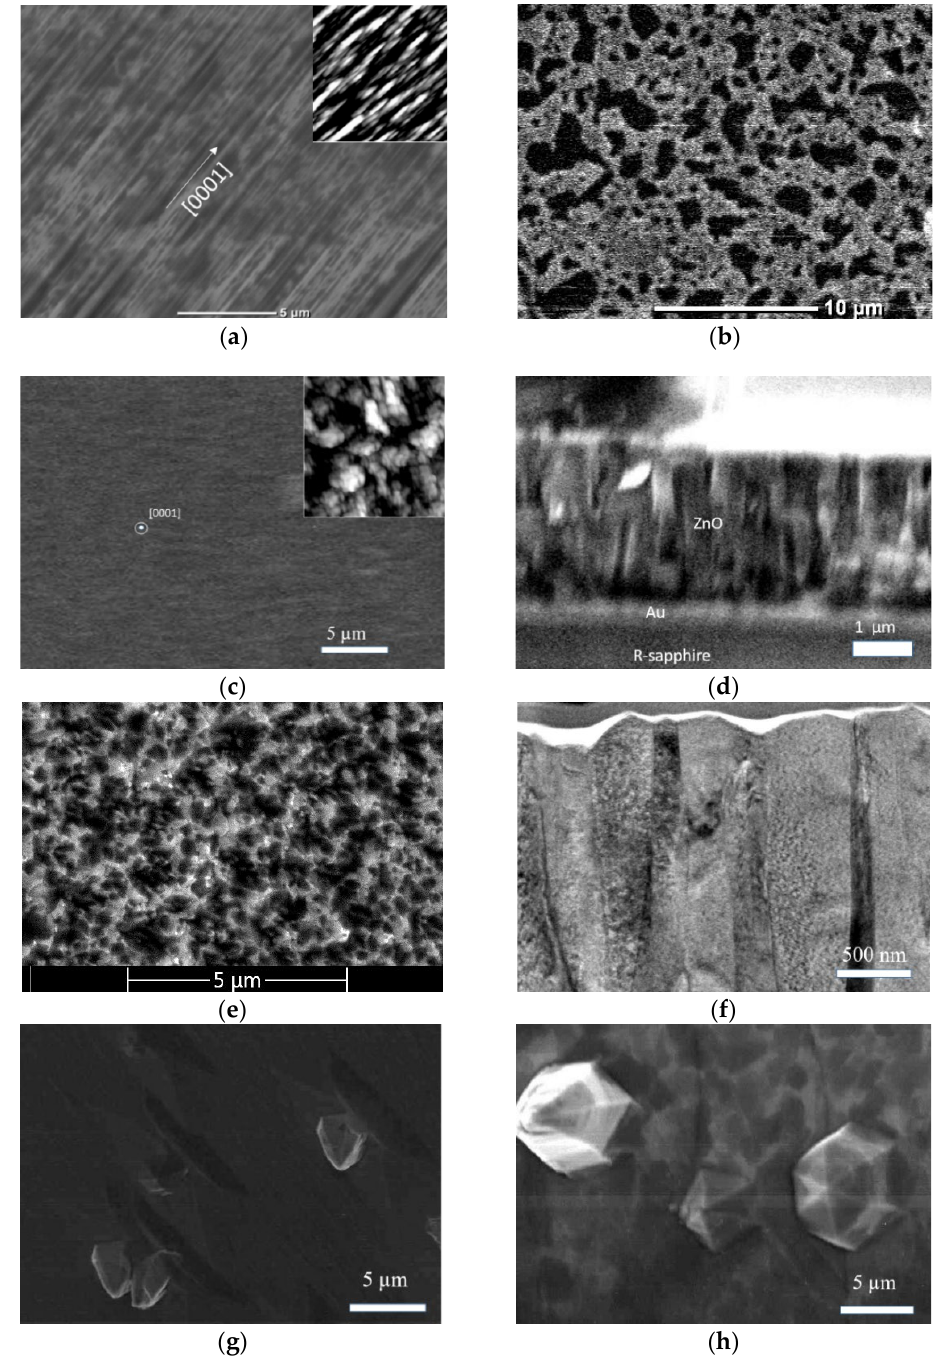
Figure 1. SEM images of ZnO films: ( a ) type R-I film surface; ( b ) porous Au film on sapphire after annealing at 730 °C; ( c ) type R-II film surface; ( d ) type R-II film cross section; ( e ) type C film surface; ( f ) cross section of type C film; ( g ) type A film surface; ( h ) type M film surface. Insets show corresponding AFM images 7 × 7 µm 2 . Table 1. Parameters of the crystal structure of ZnO films.